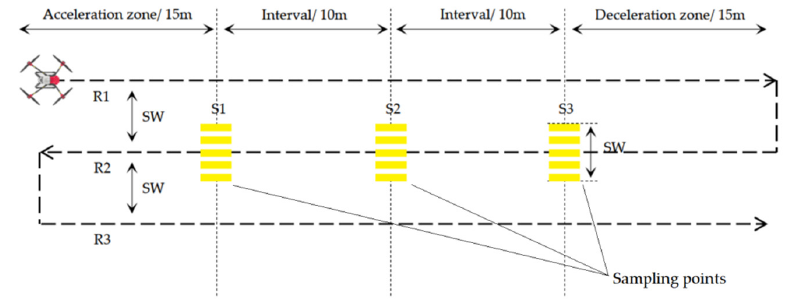
Figure 2. Arrangement of sampling points.